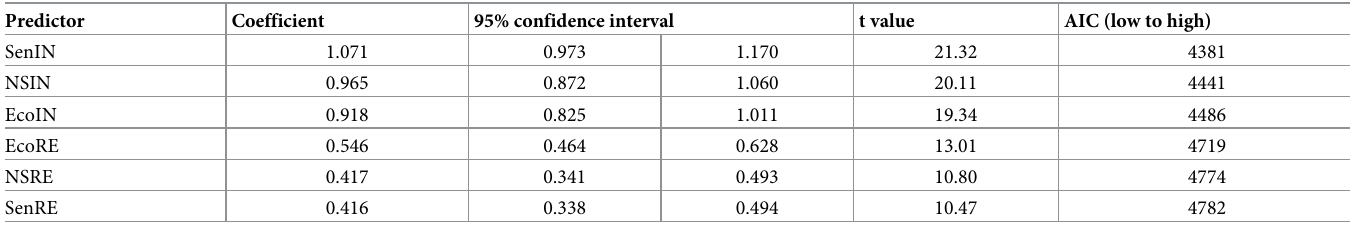
Table 4. Output of ordinal regression Model 3–8. EcoIN: The average scores for statements of intrinsic values targeting ecosystem. SenIN: The average scores for all statements of intrinsic values targeting sentient organisms. NSIN: The average scores for all statements of intrinsic values targeting non-sentient organisms. EcoRE: